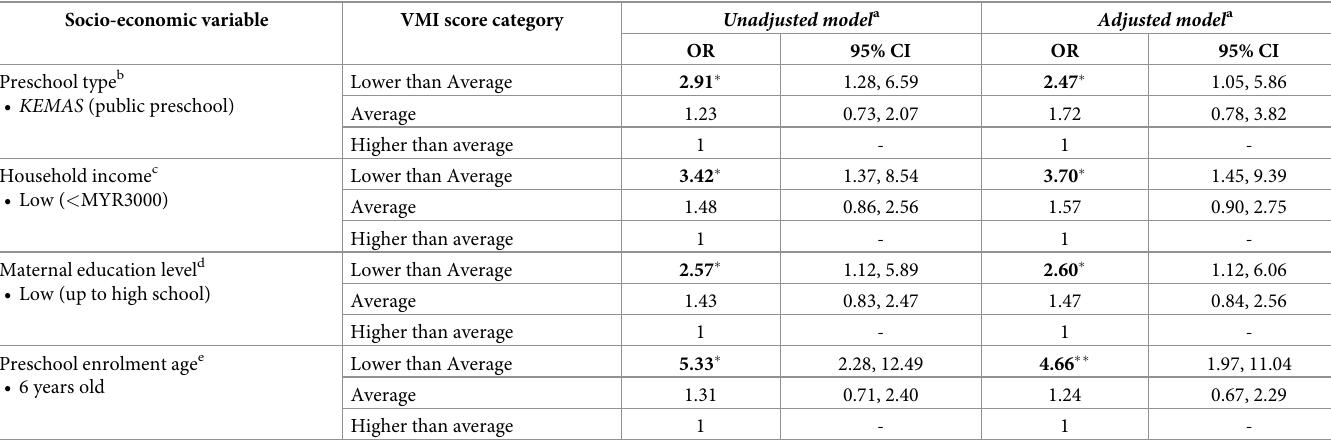
Table 6. Odds ratio for VMI performance by socioeconomic